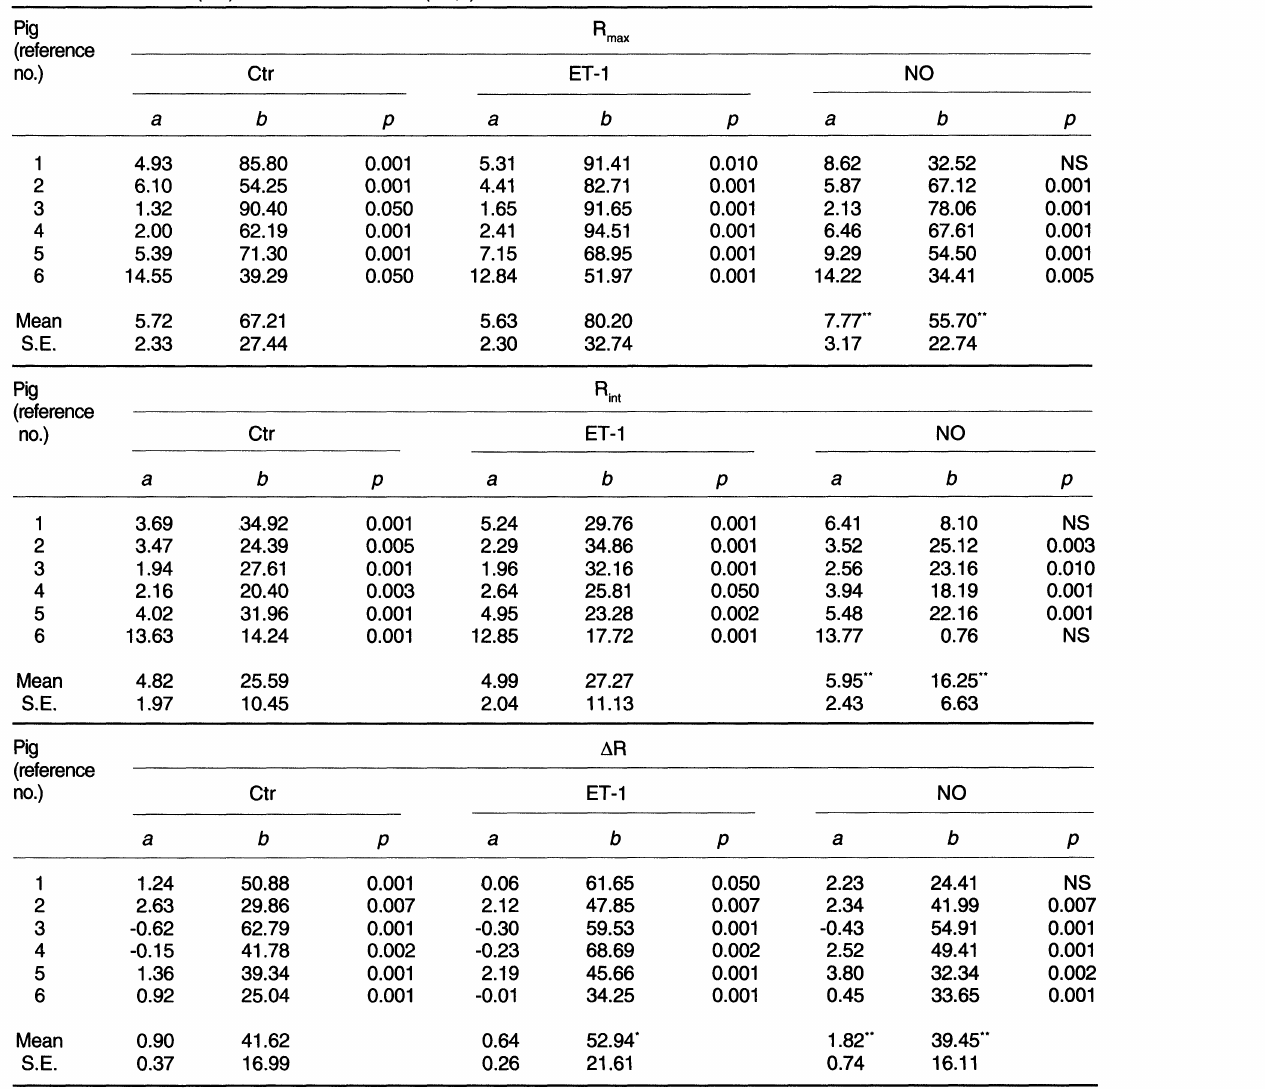
Pig Rin (reference